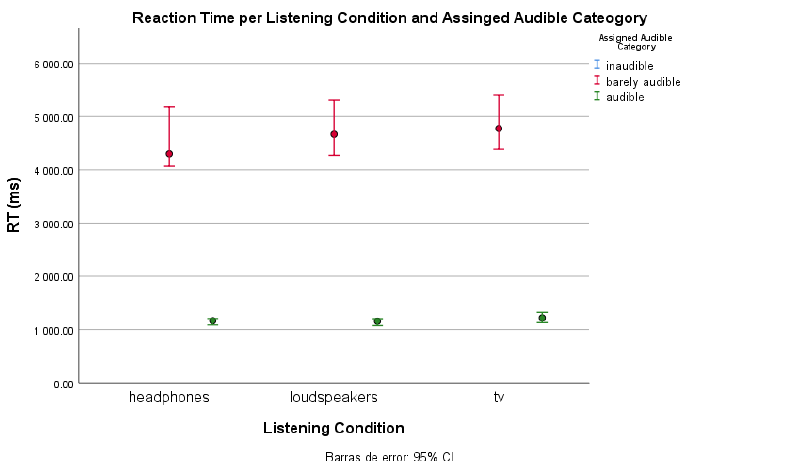
Figure 5. Median reaction time per listening condition and audibility category. There is no represen- tation of the inaudible category as the reaction time is considered